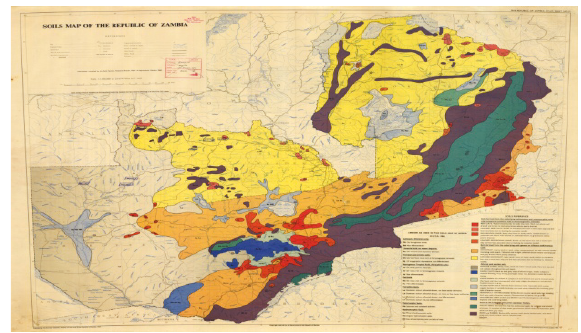
Figure 6: Soil map of Zambia which was used to obtain the soil characteristics of the four catchments under study https://www .google.co.zm/search?q=soil+map+of+zambia&rlz=1C1CHBF.